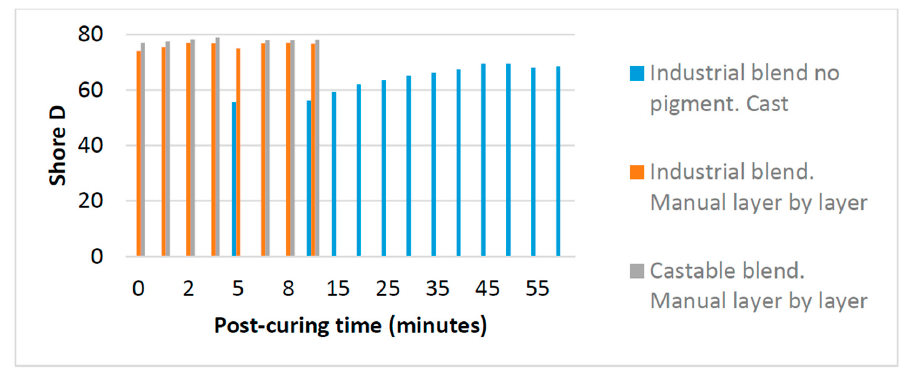
Figure 2. Comparative of shore D and post-curing time, by casting and by manual layer by layer.